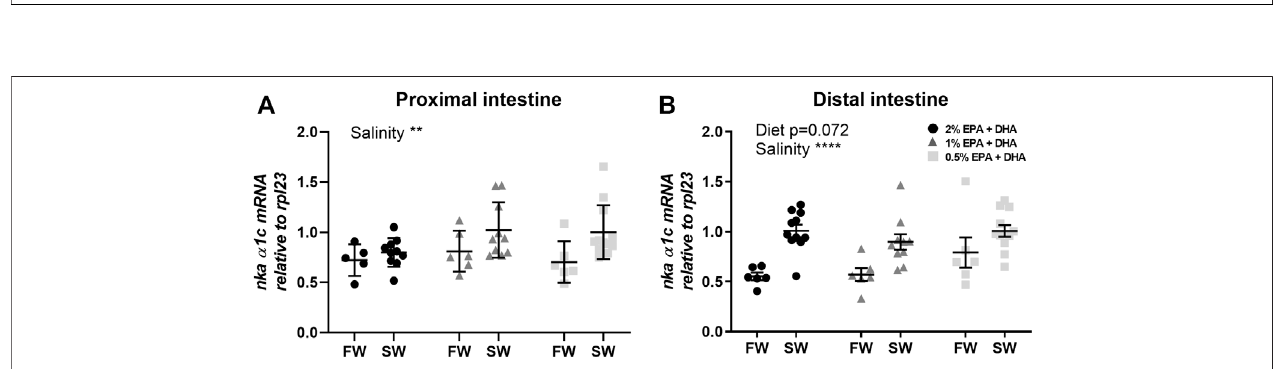
FIGURE 5 | Transcript levels of Na + /K + -ATPase ( nka ) isoform α 1c in the proximal (A) and distal (B) intestine of freshwater (FW) smolts and seawater (SW) acclimated Atlantic salmon fed different levels of omega-3. Statistics: 2-way ANOVA where main effects were compared with Tukey´s multiple comparisons test. Signi fi canteffectsfromthepost-hoctestarereportedas* p < 0.05and*** p < 0.001.Dataarepresentedasindividualvalueswiththehorizontallinerepresentingthemean and the vertical lines SEM.